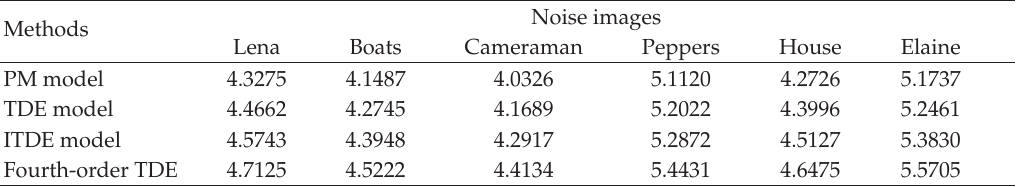
Table 3: The mean of ISNR (cid:3) in dB (cid:4) values for eight standard test images using random white Gaussian noise of variance